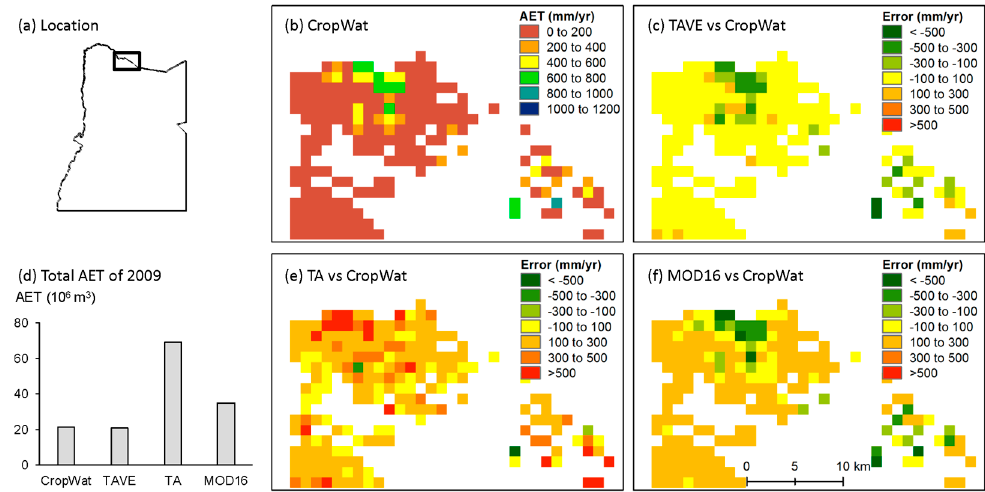
Figure 11. Comparison of different annual AET estimates for an irrigated region in 2009. ( a ) shows the location of this region within the study area. ( b ) presents the pixel-level AET estimate (mm/day) calculated by the single crop coefficient method using CropWat, assumed to be a proxy for the ground truth. ( c ) shows the absolute error of the estimates by TAVE to ( b ). ( d ) compares the basin-wide total AET estimates (10 6 m 3 /day) calculated by multiplying the pixel-level AET rate (mm/year) by the size of a pixel (km 2 ). ( e , f ) show the absolute errors of the estimates by TA and MDO16 to ( b ), respectively.